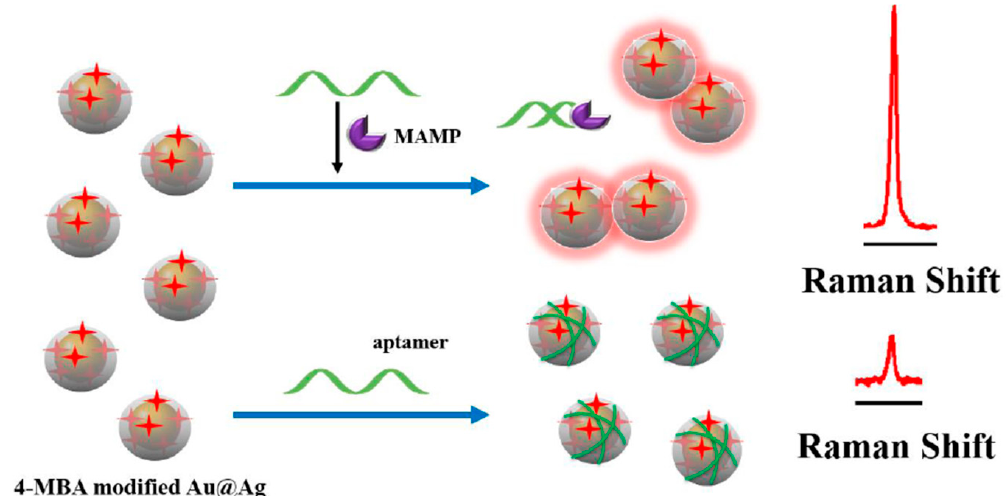
Figure 14. Schematic representation of SERS detection of methylamphetamine (MAMP) based on Au@Ag core-shell NPs. (Reprinted with permission from Elsevier, 2018 [80]).